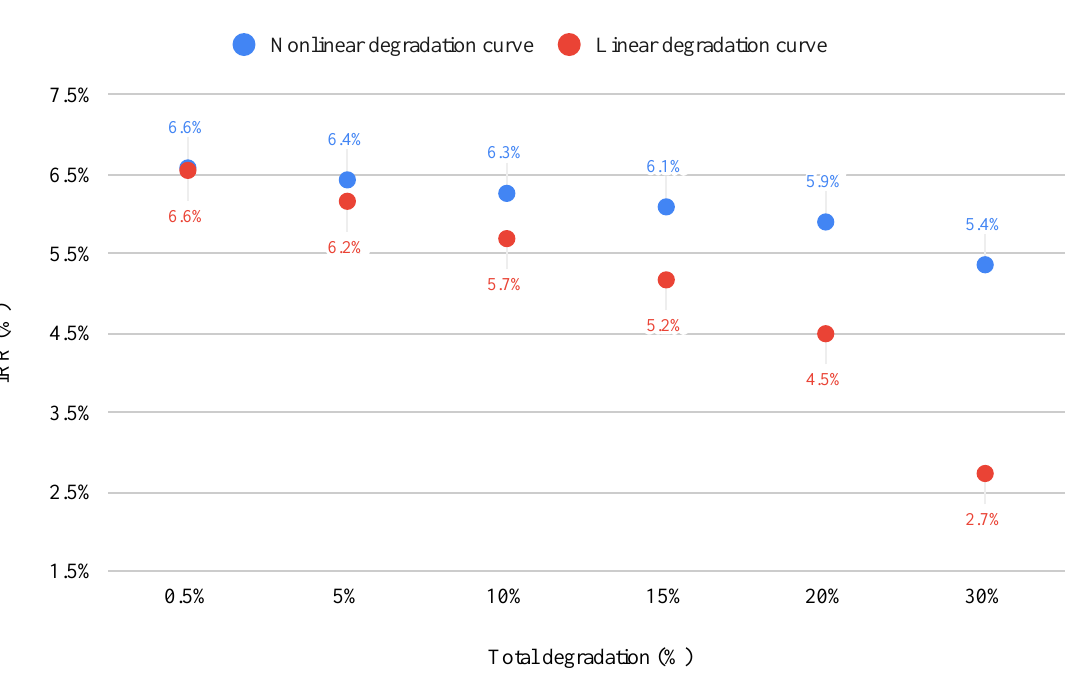
Figure 9. Equity IRRs for 55 kW rooftop PVS with contract in 2030 under different cases Source: self-elaboration.